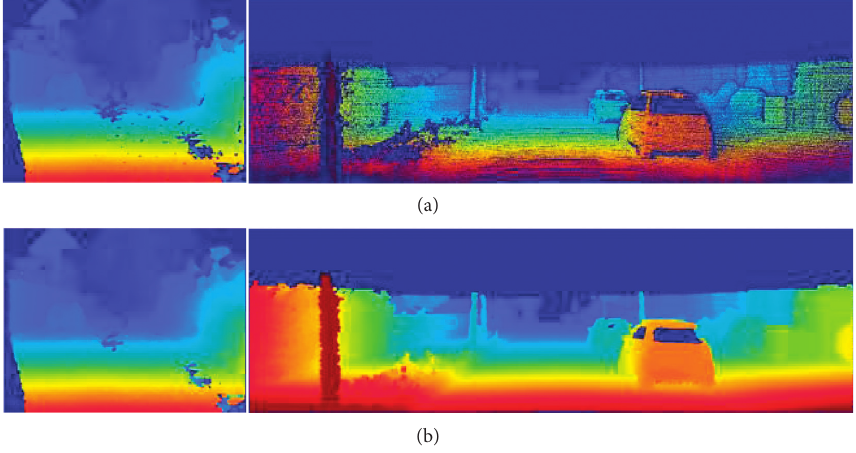
Figure 2: (a) The original disparity image and (b) the disparity image of interpolation